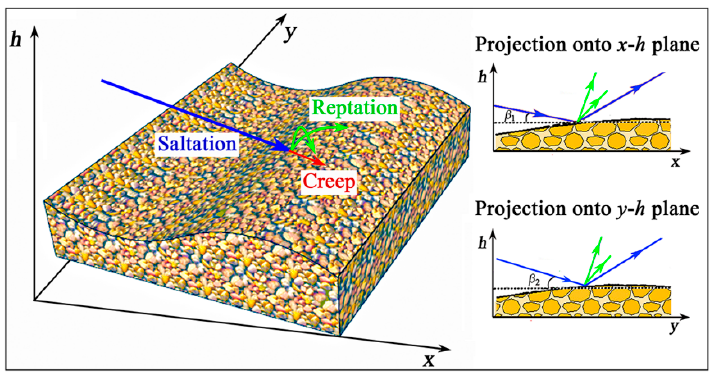
Figure 1. Sketch of the model’s